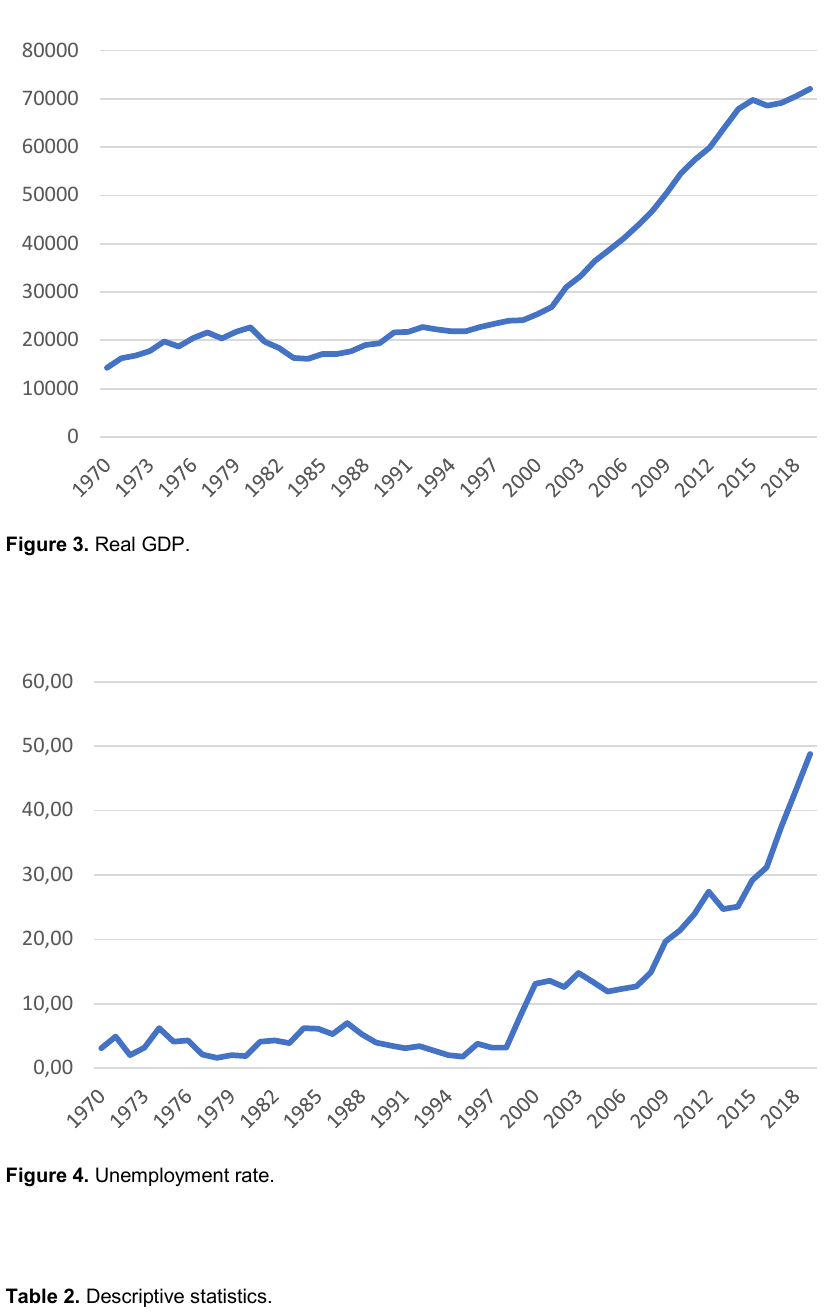
Table 2. Descriptive